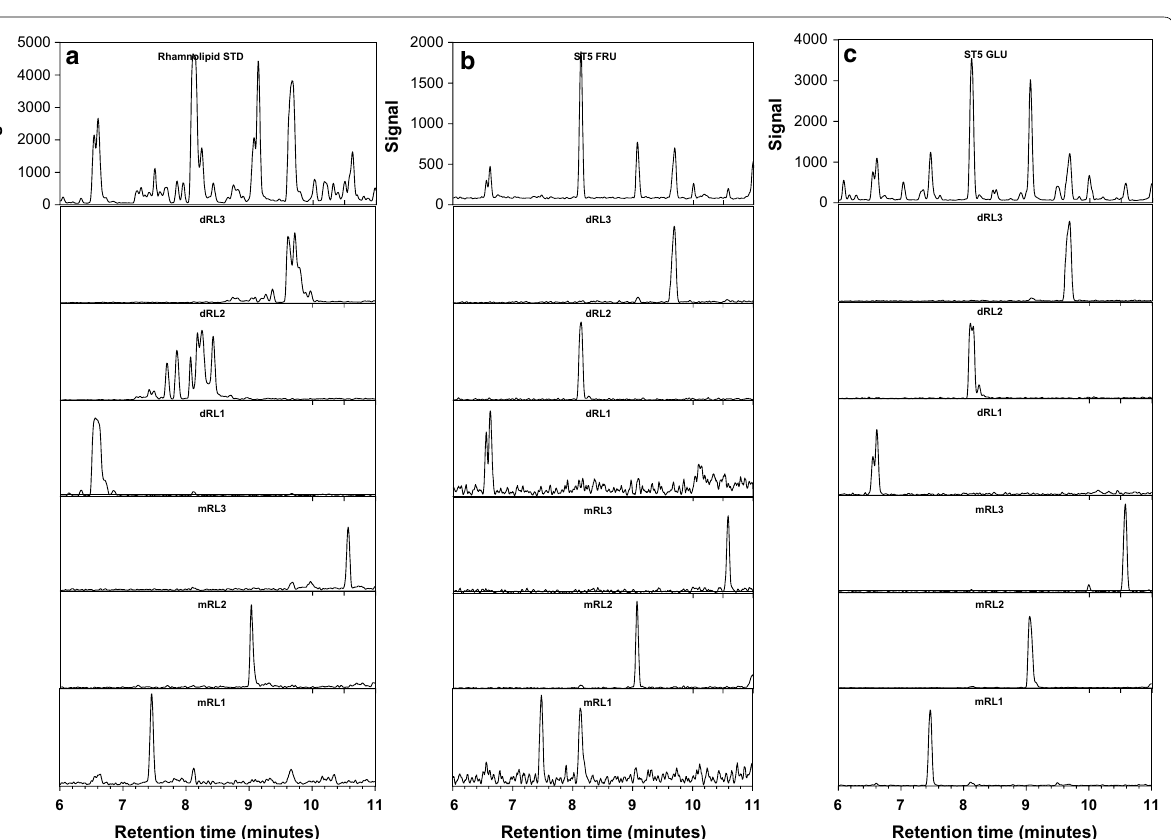
Fig. 3 UPLC–MS profiles of rhamnolipid standard ( a ); ST5 Fructose-MSM extract ( b ); ST5 Glucose-MSM extract ( c ). The top row profiles show the signal of positive molecular ions detected between 6 and 11 min. Note the difference in Y axis which is a direct indication of amounts. The profiles below each top row spectrum show the extracted spectra of the rhamnolipid